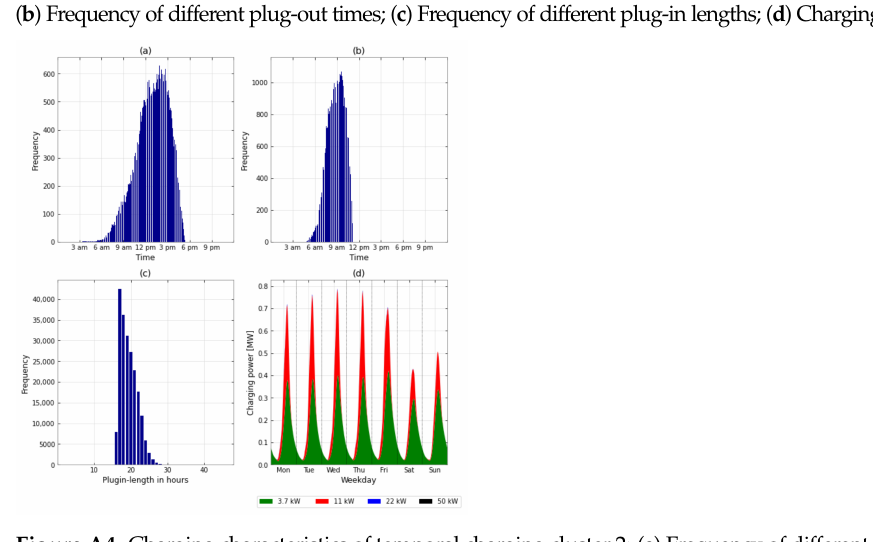
Figure A4. Charging characteristics of temporal charging cluster 2: ( a ) Frequency of different plug-in times; ( b ) Frequency of different plug-out times; ( c ) Frequency of different plug-in lengths; ( d ) Charging power